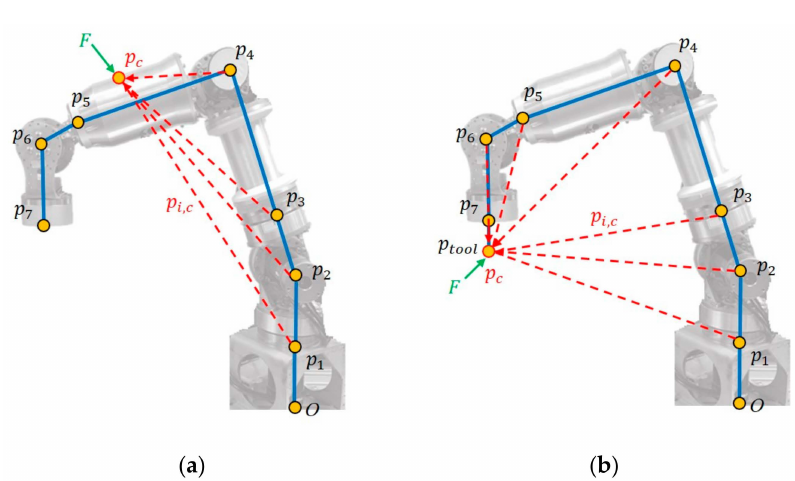
Figure 1. ( a ) Contact force on link 4; ( b ) Contact force on end-e ff